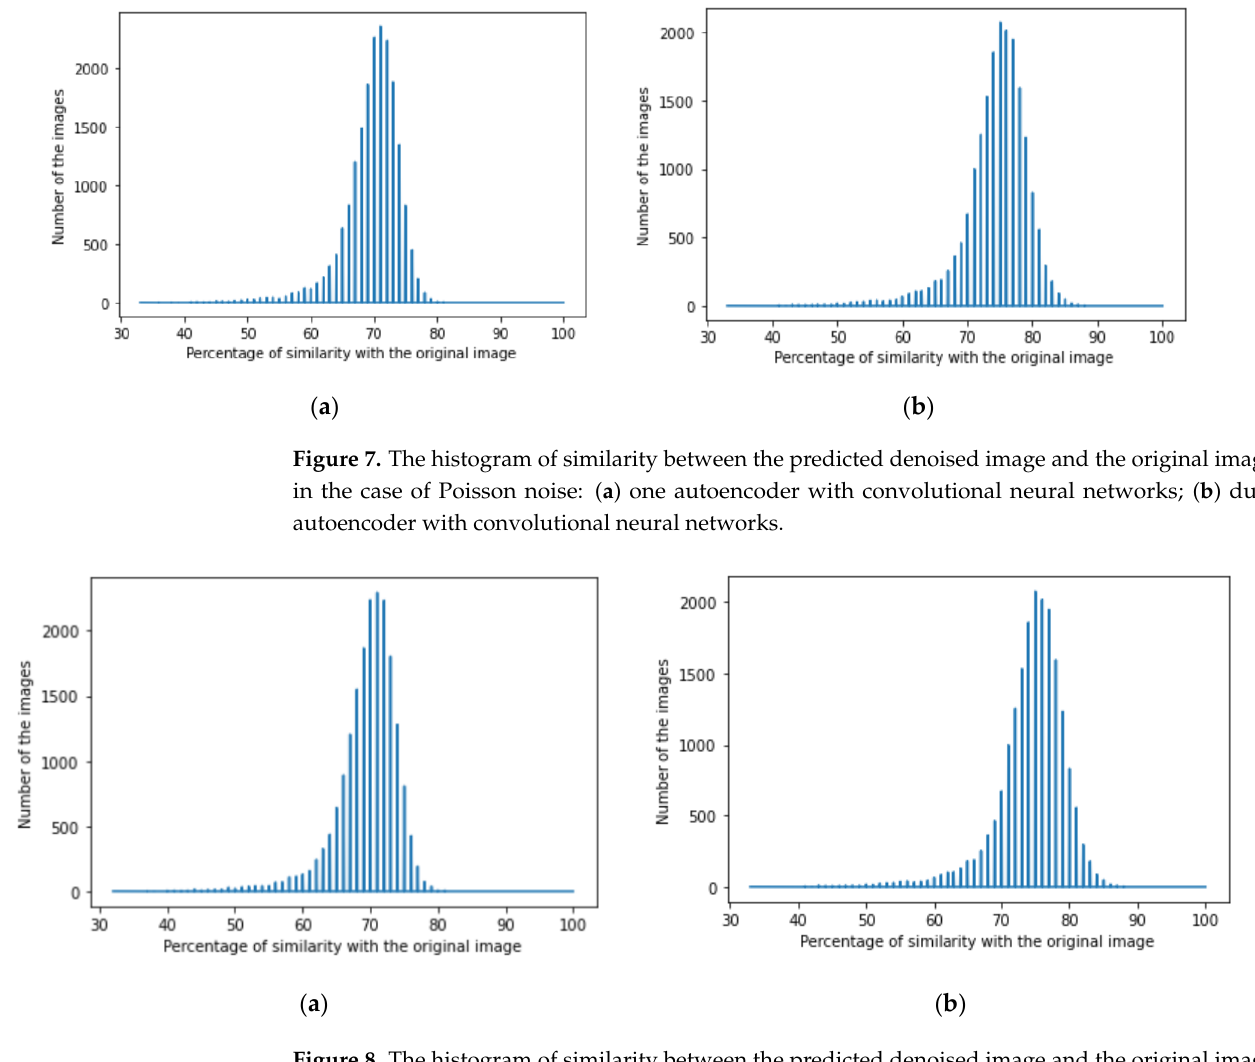
Figure 6. The histogram of similarity between the predicted denoised image and the original image in the case of Gaussian noise: ( a ) one autoencoder with separable convolutional neural networks; ( b ) dual autoencoder with separable convolutional neural networks.